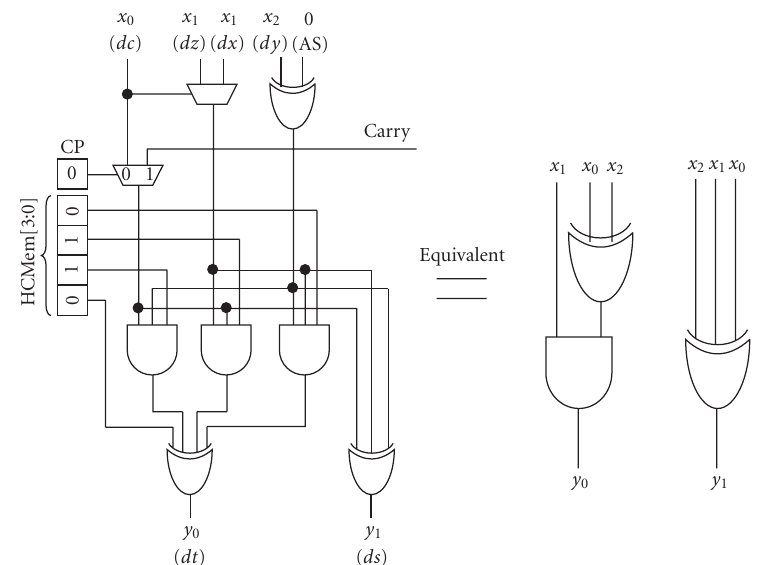
Figure 8: Example of a three-input misc. logic function.